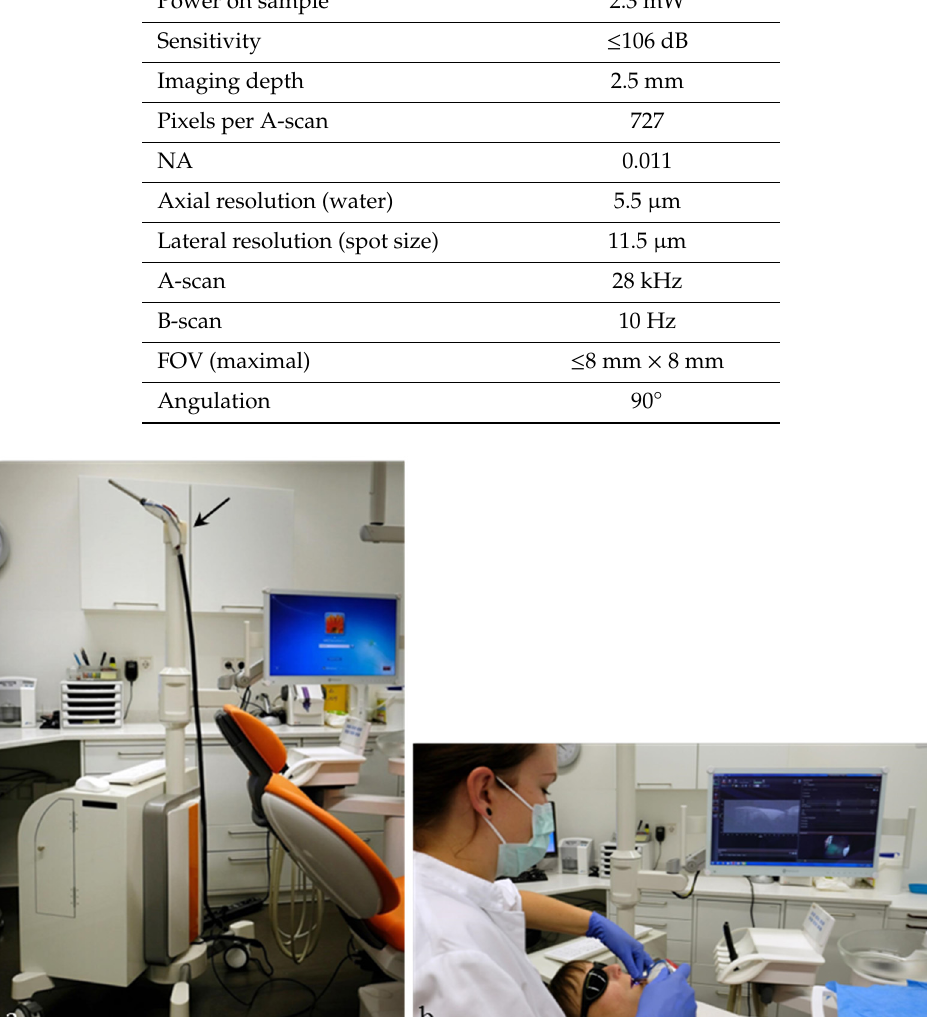
Figure 3. The system set-up with the intraoral OCT probe (( a ), arrow) permits chairside the intraoral diagnosis in communication with the patient ( b ).